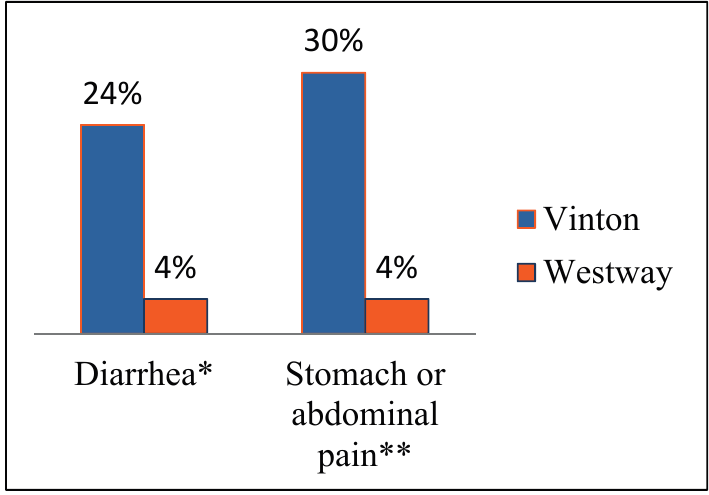
Figure 4. Proportion of households drinking tap water and reporting ailments in the last 30 days. * Significant difference between communities using chi-square test, p = 0.03 (x 2 = 4.91). ** Significant difference between communities using chi-square test, p = 0.007 (x 2 = 7.02).